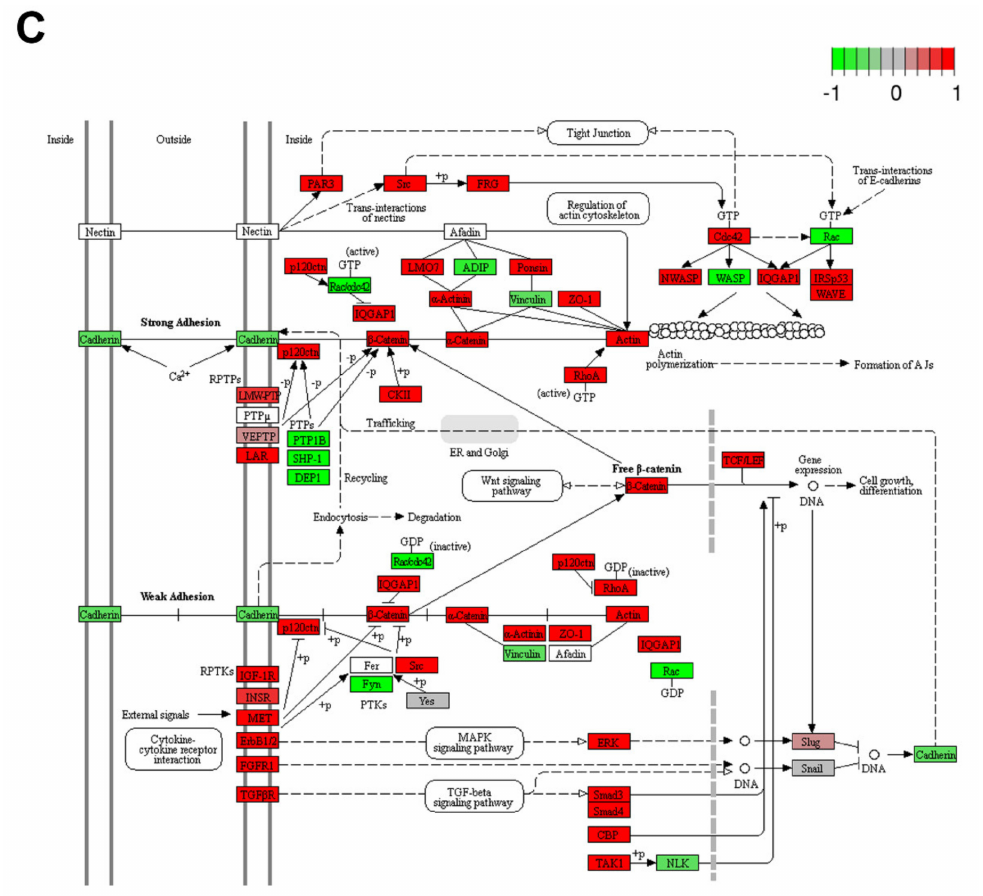
Figure 5. The adherens junctions pathway is significantly enriched in the CTC-S group. ( A ) Venn plot of enriched pathways in di ff erentially expressed genes and weighted gene co-expression network analysis (WGCNA). Six pathways included focal adhesion (KEGG: 04510), ECM-receptor interaction (KEGG: 04512), adherens junction (KEGG: 04520), AGE-RAGE signaling pathway in diabetic complications (KEGG: 04933), proteoglycans in cancer (KEGG: 05205) and fluid shear stress and atherosclerosis (KEGG: 05418) were significantly enriched in both di ff erentially expressed genes and WGCNA. ( B ) The intersection of enriched genes in the adherens junction pathway of di ff erentially expressed genes, enriched genes in the adherens junction pathway of the brown module in WGCNA, and hub genes. Ctnnb1 is at the intersection of all three lists. ( C ) Gene expression in the adherens junction pathway was plotted by PATHVIEW [33]. Red represents up-regulated genes, while green represents down-regulated genes in the CTC-S group. The Venn plots in this study were generated by imageGP (available online: http: // www.ehbio.com / ImageGP / index.php / Home / Index / index.html, accessed on 23 April